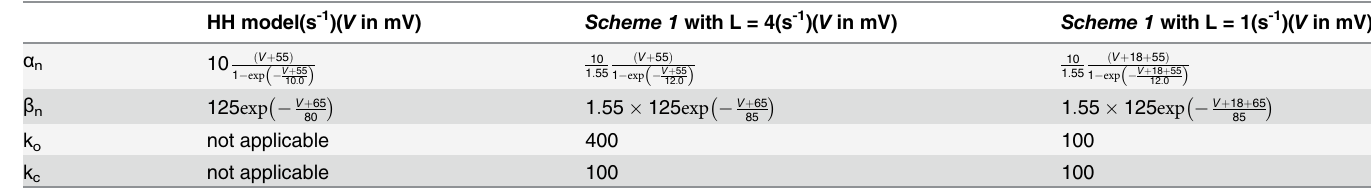
Table 3. Parameters for two sub-populations of Kv (one MS, one not) used to study the effect of a MS-Kv on HH type excitability. HH model(s -1 )( V in mV) Scheme 1 with L = 4(s -1 )( V in mV) Scheme 1 with L = 1(s -1 )( V in